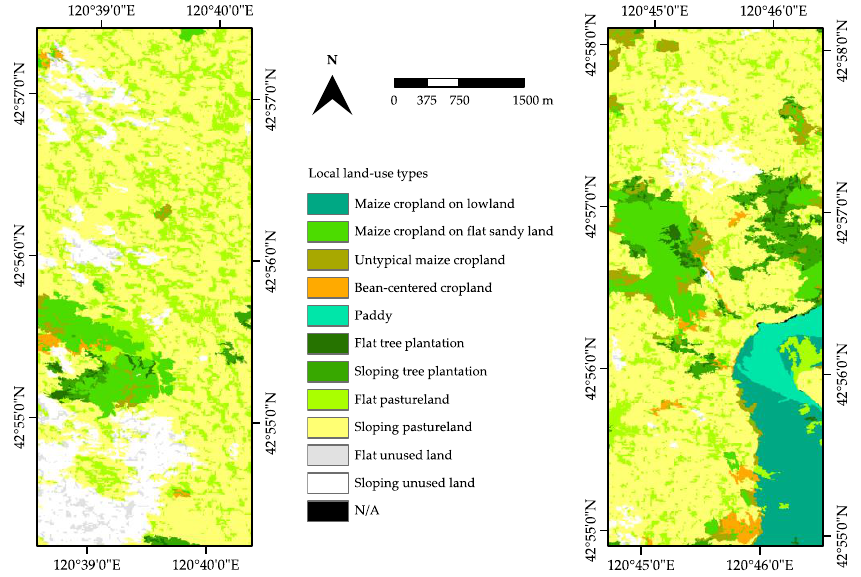
Figure 3. Local land-use map of the study sites in the Horqin Sandy Land, resulting from the overlay of object-based preliminary land-use classification and GIS-based topography classification. Mongolian people constitute the majority of residents on in area on left, and Han people on